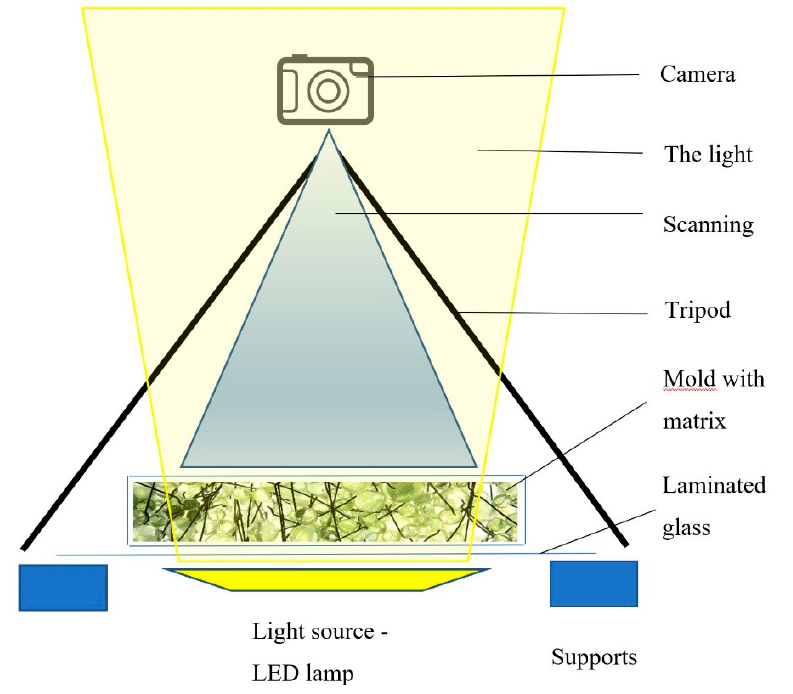
Figure 9. Illustration of the experiment shooting.